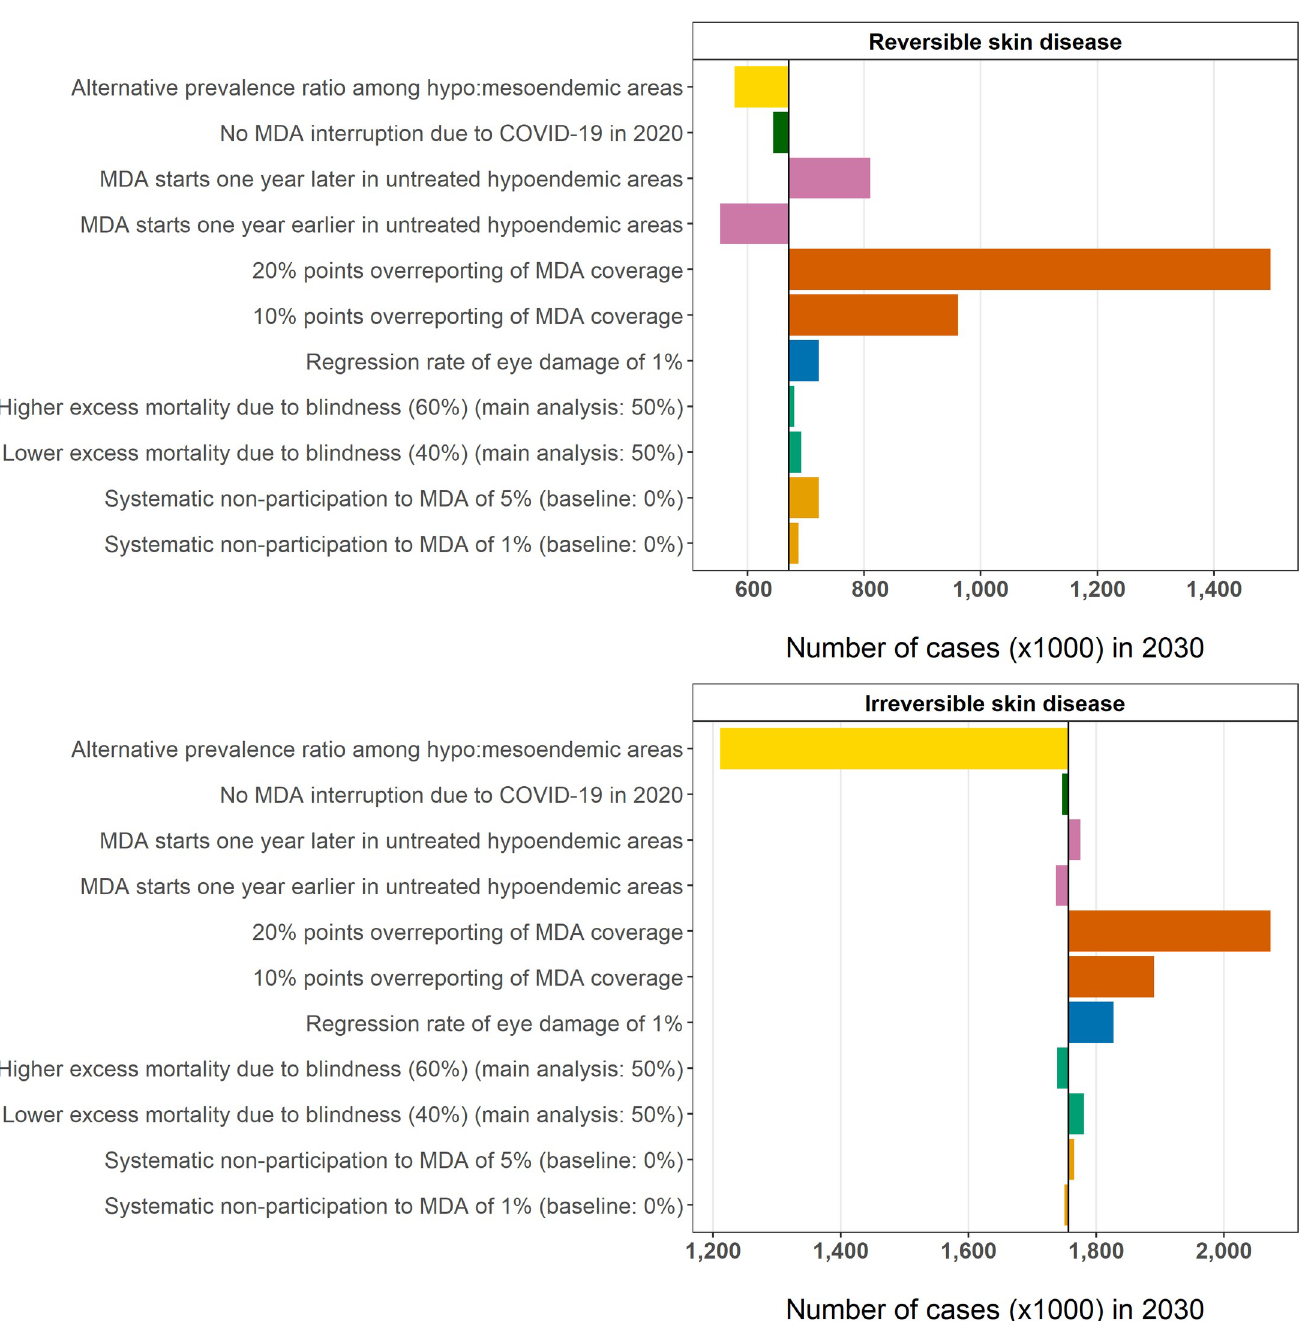
Fig 3. Univariate sensitivity analysis for the predicted number of cases with reversible and irreversible onchocercal skin disease by 2030. Coloured bars represent the difference between the sensitivity analysis and the results of the main analysis (vertical black line). � In the sensitivity analysis, the prevalence of infection and clinical manifestations in hypoendemic areas was assumed to be 1/3 of that in mesoendemic areas (as applied in a previous modelling exercise [2]), instead of ratios based on a more detailed meta-analysis performed for the main analysis (see also Table E in S1 Text